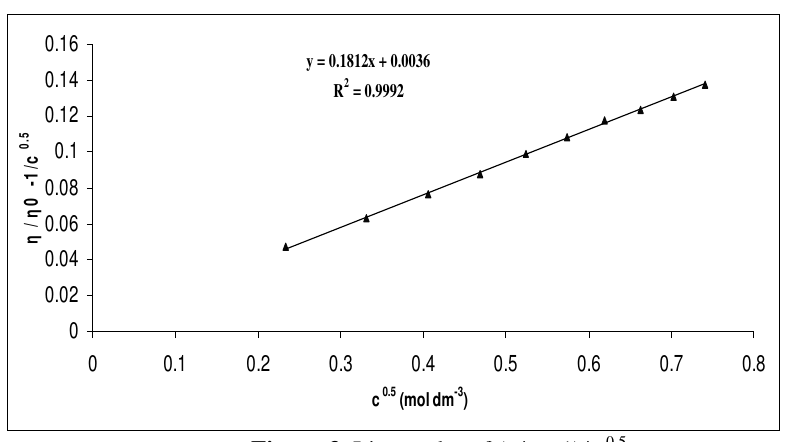
Figure 3. Linear plot of ( (cid:5) / (cid:5) 0 -1)/ c 0.5